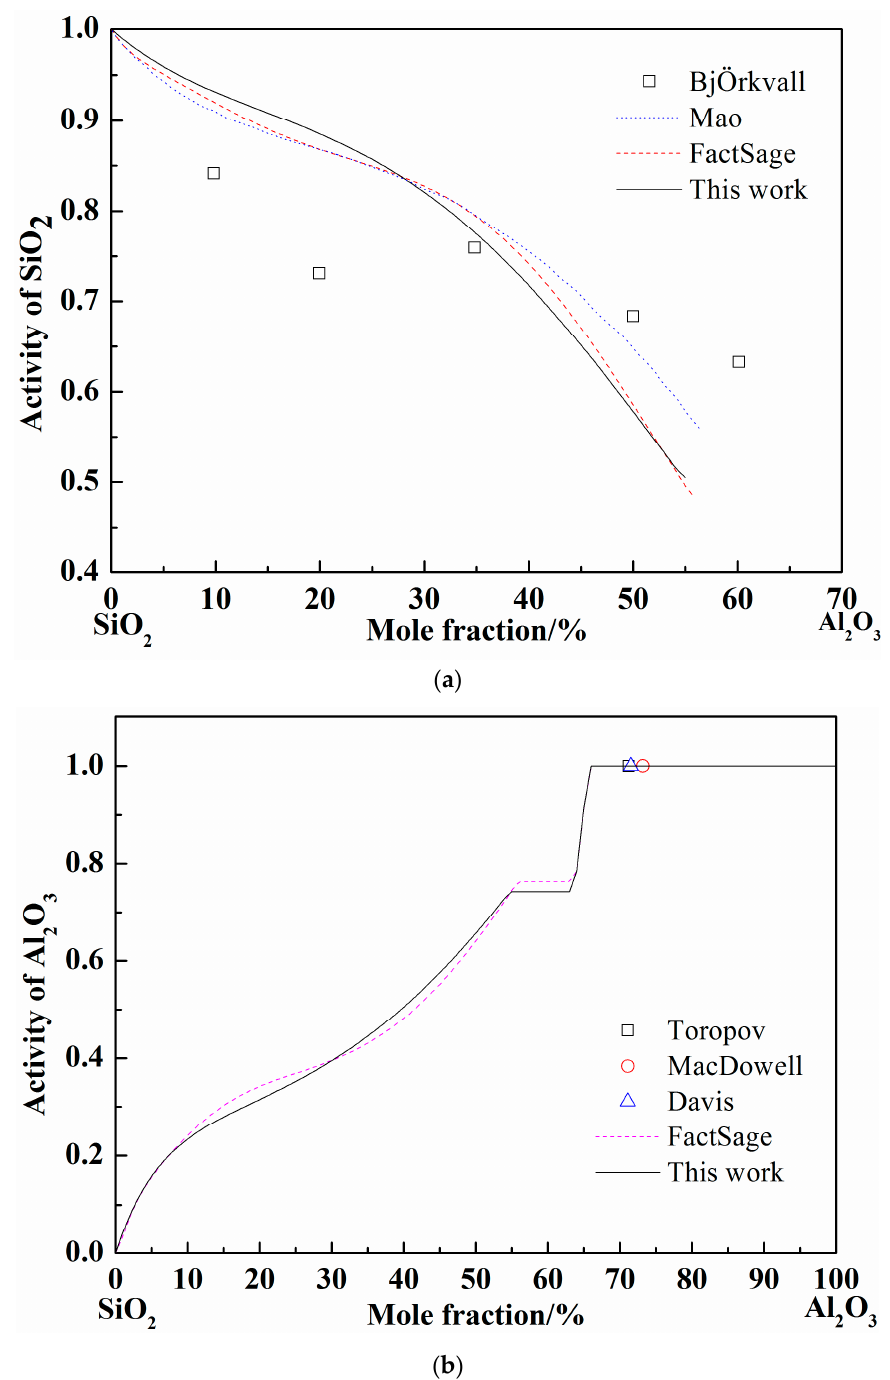
Figure 3. Calculated activity curves in the SiO 2 -Al 2 O 3 system at 1877 °C. ( a ) The SiO 2 activity in SiO 2 - Al 2 O 3 system; ( b ) The Al 2 O 3 activity in SiO 2 -Al 2 O 3 system. SiO 2 -Al 2 O 3 system; ( b ) The Al 2 O 3 activity in SiO 2 -Al 2 O 3